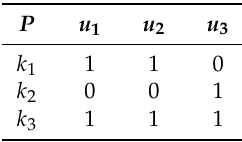
Table 2. Soft set ( P , M ) .